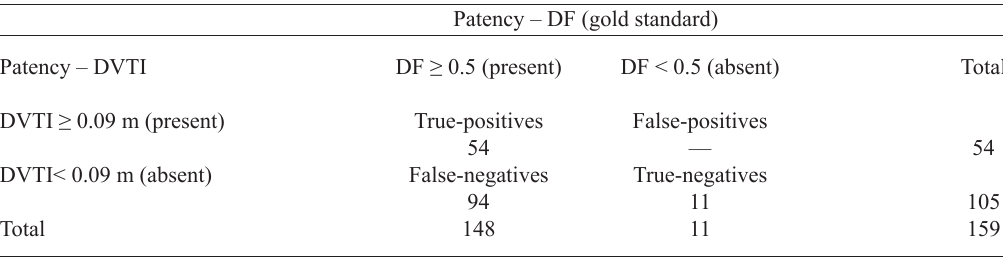
Table 3. Detecting composite graft patency (present or absent) using DVTI, with DF as the gold standard. Data obtained from 38 patients.